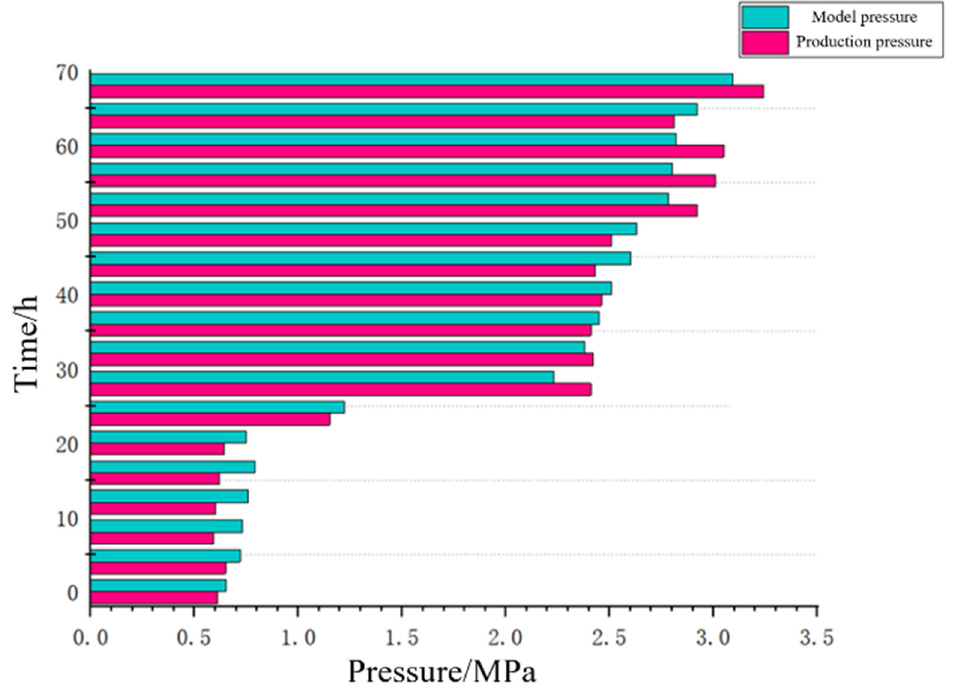
Figure 12. Comparison of the inlet pressure at pump station #2.